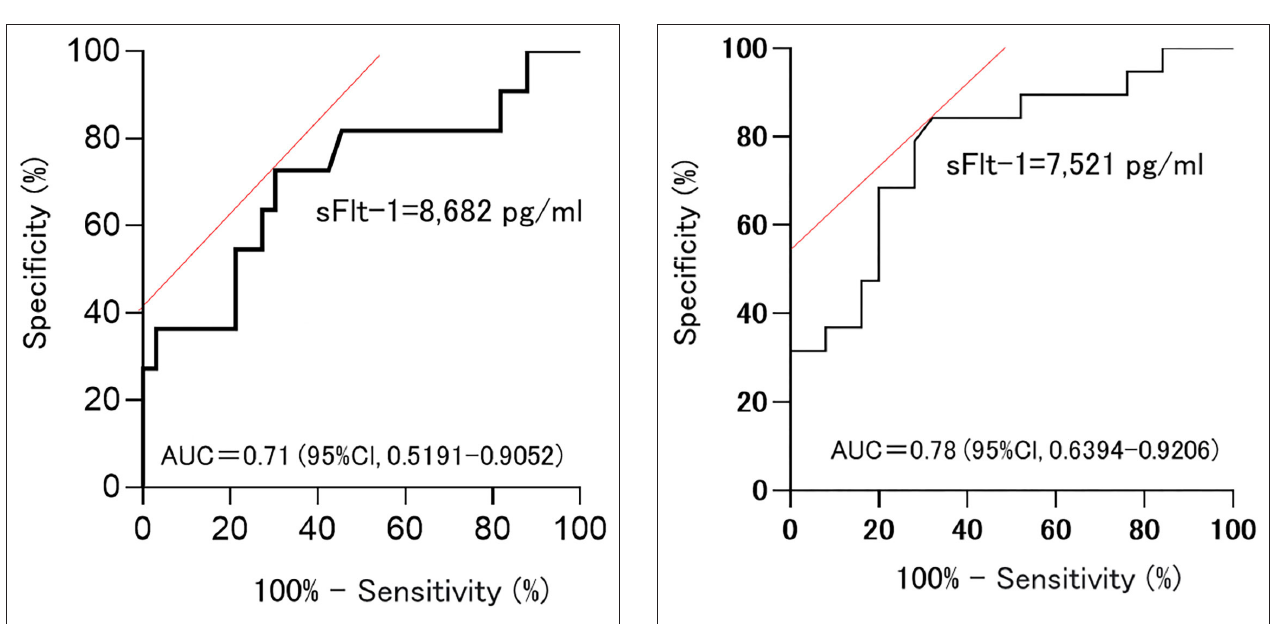
FIGURE 3 | Cutoff values for delivery in < 24h; Cutoff values of 8,682.1 pg/ml (AUC 0.71; 95%Cl, 0.5191–0.9052).